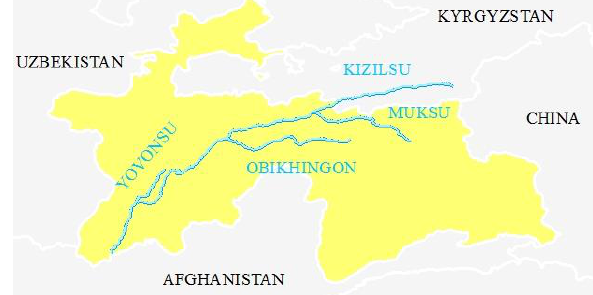
Figure 1. The location of the Vakhsh River